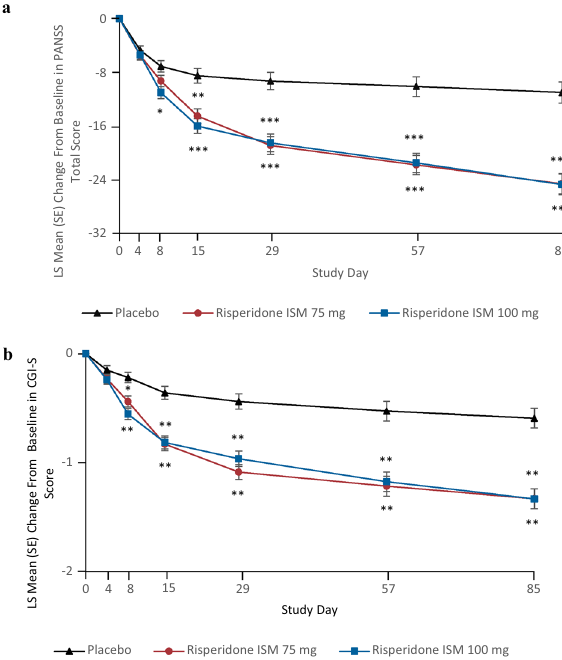
Fig. 2 LS mean change from baseline at each time point (mITT population). a PANSS total score, where mean PANSS score at baseline for placebo = 96.4 (SD: 7.21), for Risperidone ISM 75 mg = 96.3 (SD: 8.47) and for Risperidone ISM 100 mg = 96.1 (SD: 8.42). The error bars represent SE and P values are for Risperidone ISM 75 mg and Risperidone ISM 100 mg dose group versus placebo (* p < 0.01, ** p < 0.001, *** p < 0.0001), in b CGI-S Score, where mean CGI-S score at baseline for placebo = 4.9 (SD: 0.54), Risperidone ISM 75 mg = 4.9 (SD: 0.63) and Risperidone ISM 100 mg = 4.8 (SD: 0.53). The error bars represent SE and P values are for Risperidone ISM 75 mg and Risperidone ISM 100 mg dose group versus placebo (* p < 0.01, ** p <